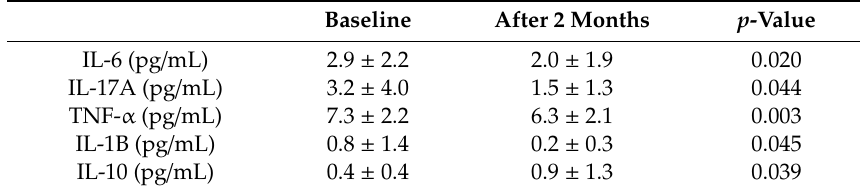
Table 2. E ff ect of EVOO with a high OC concentration on plasma cytokines. Baseline